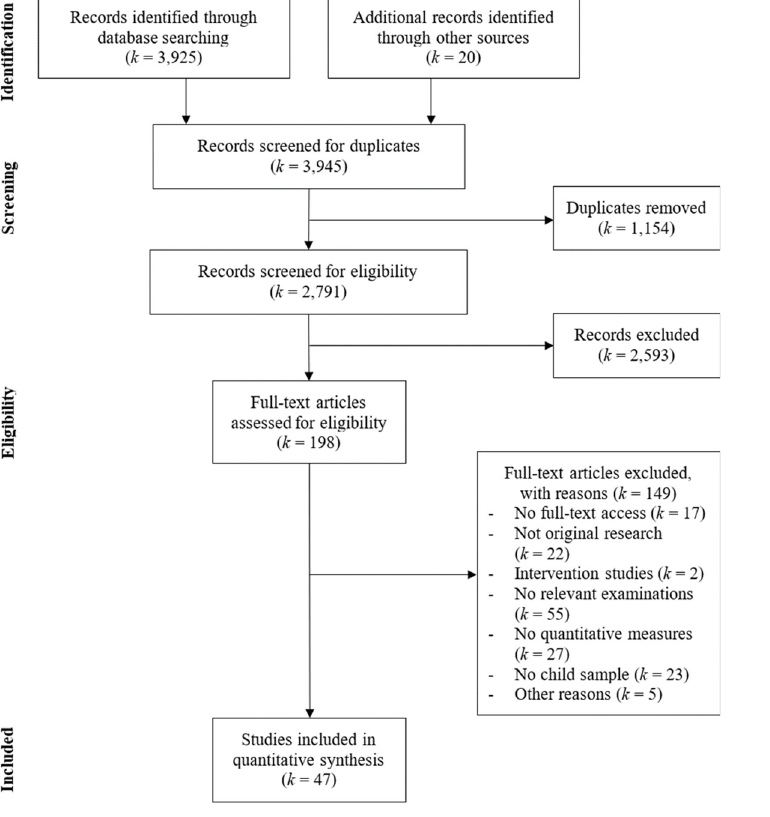
Fig 1. PRISMA flow diagram of literature